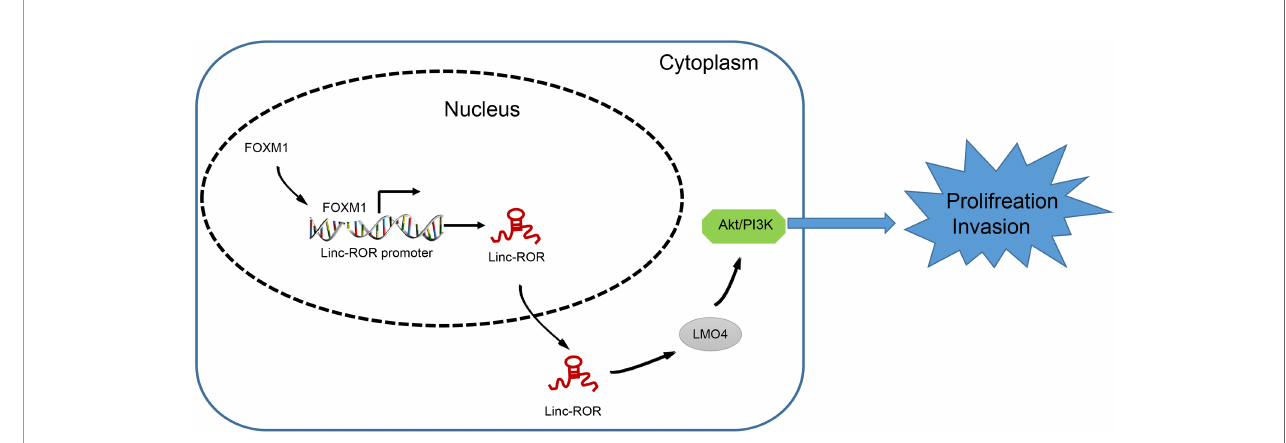
FIGURE 6 | The mechanism of FOXM1 unveiled in the present study may provide an insight for the development of new targets